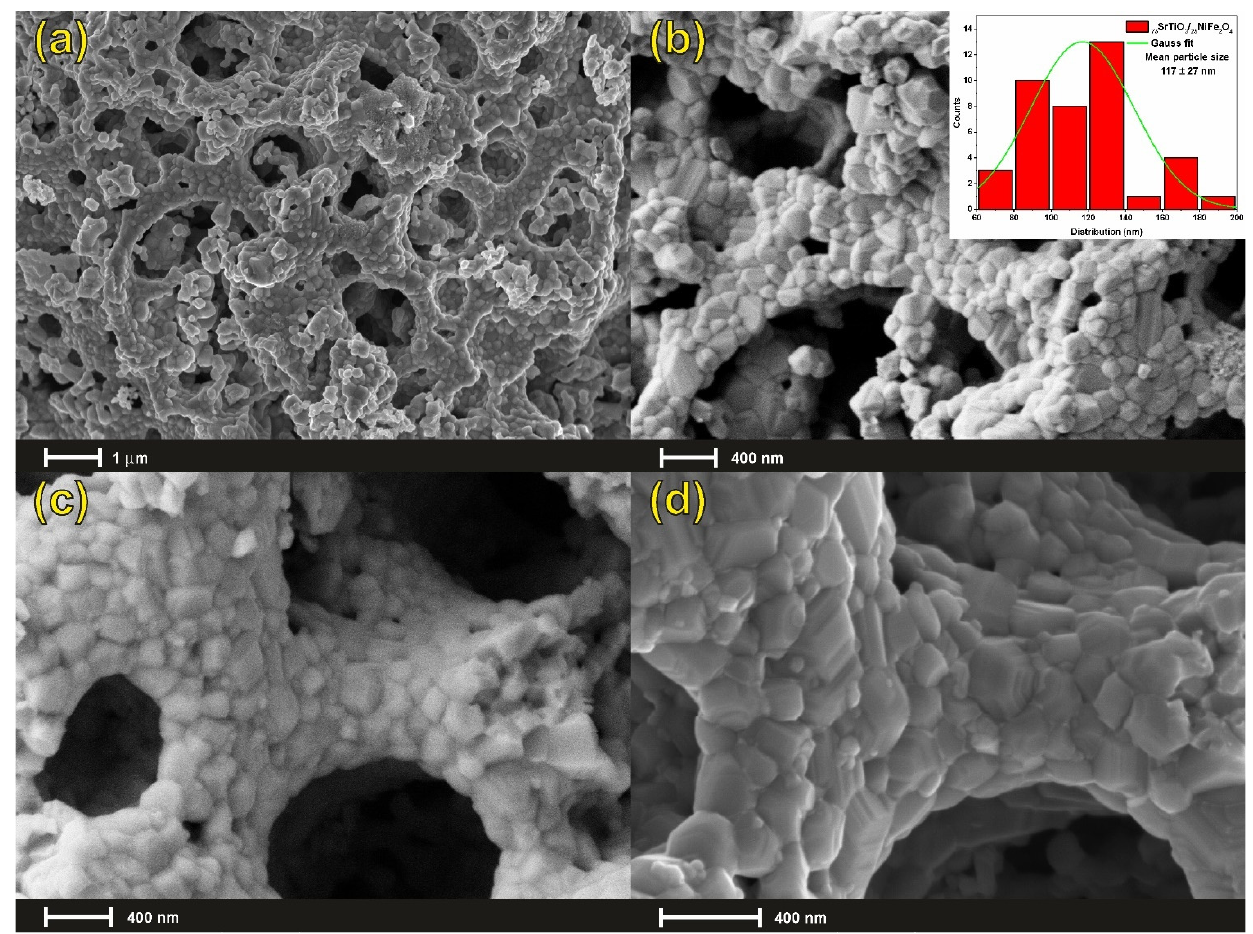
Figure 2. FE-SEM image of the porous structure ( a ) [scale 1 µm, electron high tension EHT = 5 KV and MAG = 10 kX], ( b ) [scale 400 nm, electron high tension EHT = 1.8 KV and MAG = 25 kX], ( c ) [scale 400 nm, electron high tension EHT = 5 kV and MAG = 30 kX], and ( d ) [scale 400 nm, electron high tension EHT = 5 KV and MAG = 45 kX], formed from the auto-combustion of hybrid 3D hierarchical xerogel composed of SrTiO 3 nanoparticles, nickel, and iron glycinate. Histogram (b-inserted) showing the particle size distribution of the 75 STO/ 25 NFO [SD: ±27 nm].